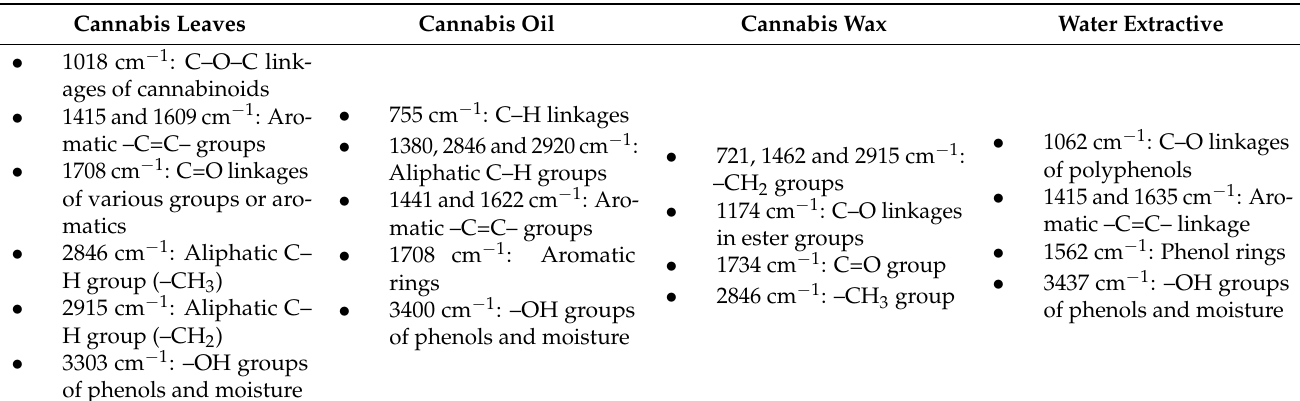
Table 6. Peak assignments for FTIR spectra of cannabis leaves, oil, wax and water extractive.